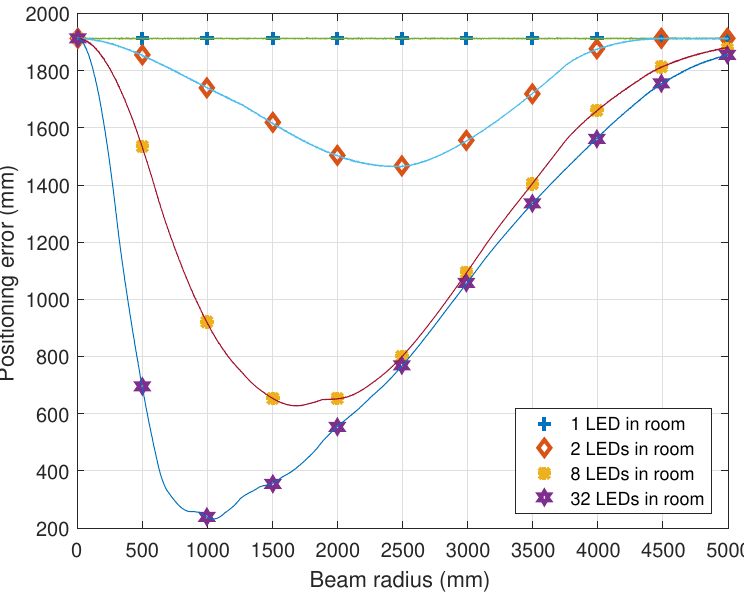
Figure 7. Positioning error as the beam radius and the number of LEDs in a room are increased.